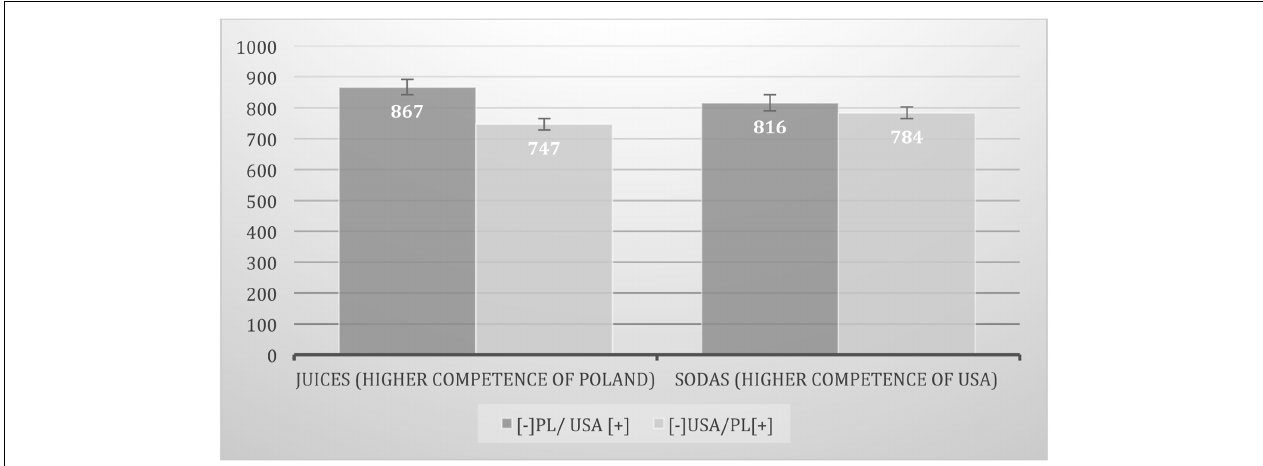
FIGURE 5 | Comparison of ICE toward Polish (local) vs. American (foreign) existed brands (IAT effect) in two product categories of different level of competence: (a) juices – higher competence of Poland and (b) sodas – higher competence of USA. Categorization time in milliseconds